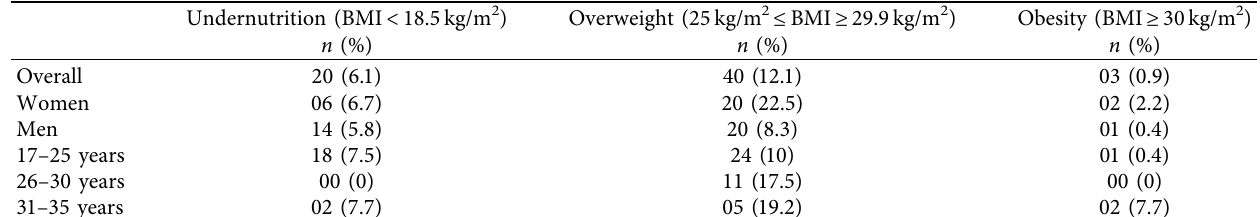
Table 5: Prevalence of malnutrition among students of the University of